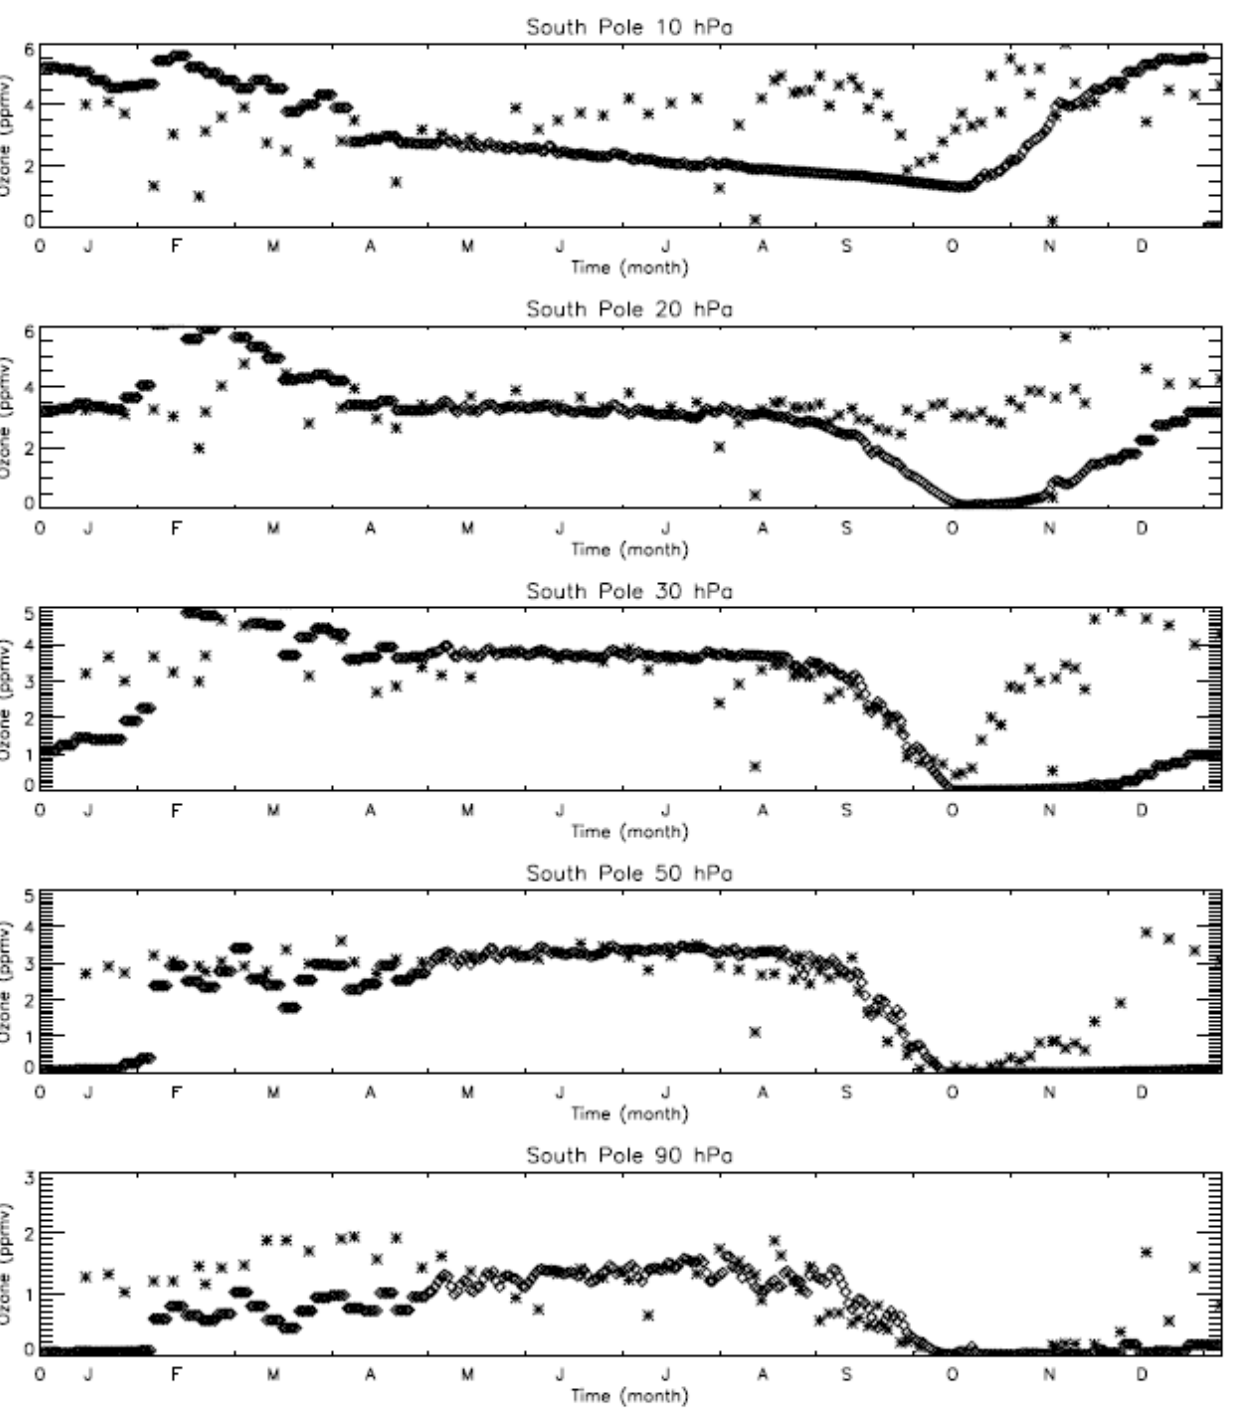
Fig. 15. Evolution of the measured (crosses) and simulated (diamonds) ozone mixing ratios at South Pole at 10, 20, 30, 50 and 90hPa for the year Figure 15: Evolution of the measured (crosses) and simulated (diamonds) ozone 4 mixing ratios at South Pole at 10, 20, 30, 50 and 90 hPa for the year 1993. 5